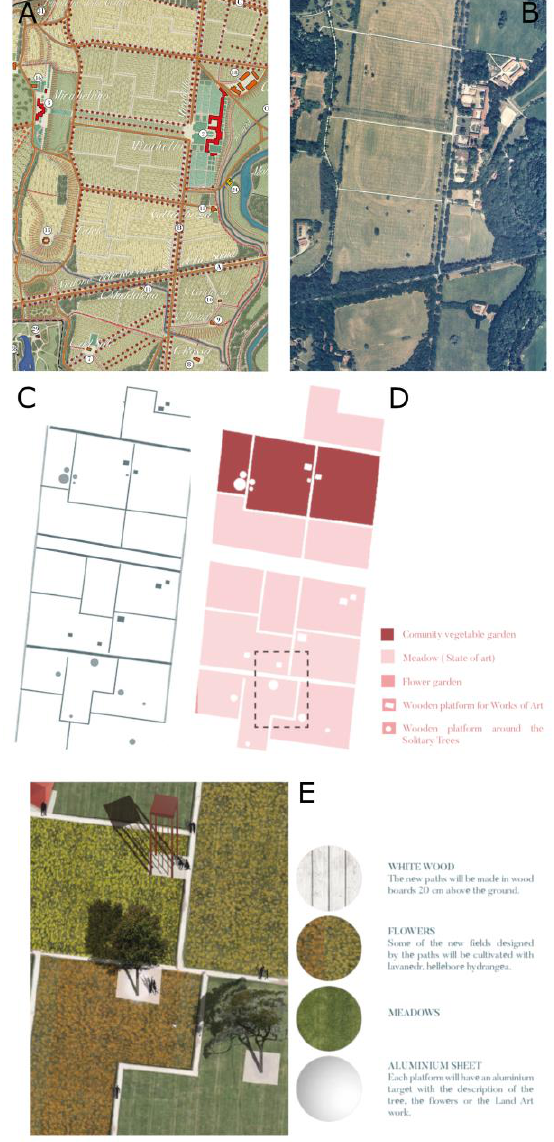
Figure 4. Master Plan proposal for the Royal Park of Monza: Brenna’s map (A) shows the clear presence of different types of crops, paths and water network, while the current aerial view (B) shows mostly meadows. The project wants to re-discover old, often hidden, traces and use them to re-create a new landscape: the old fields drawing is re-created with wood paths; each sector is filled with flowers and vegetable gardens (C-D). Where paths cross a tree or a land art installation, it becomes an exhibition platform or rest area